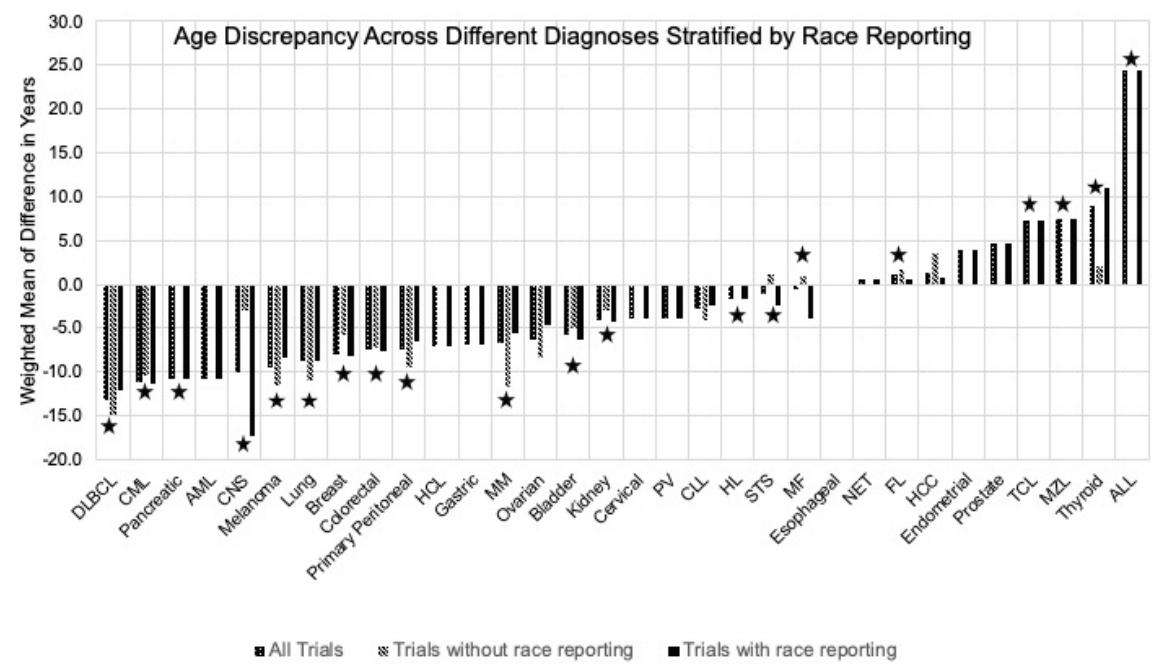
Figure 3. Graphical representation of discrepancy in age between clinical trial populations and real-world patients according to the cancer type and race reporting. Starred groups indicate presence of statistically significant difference.